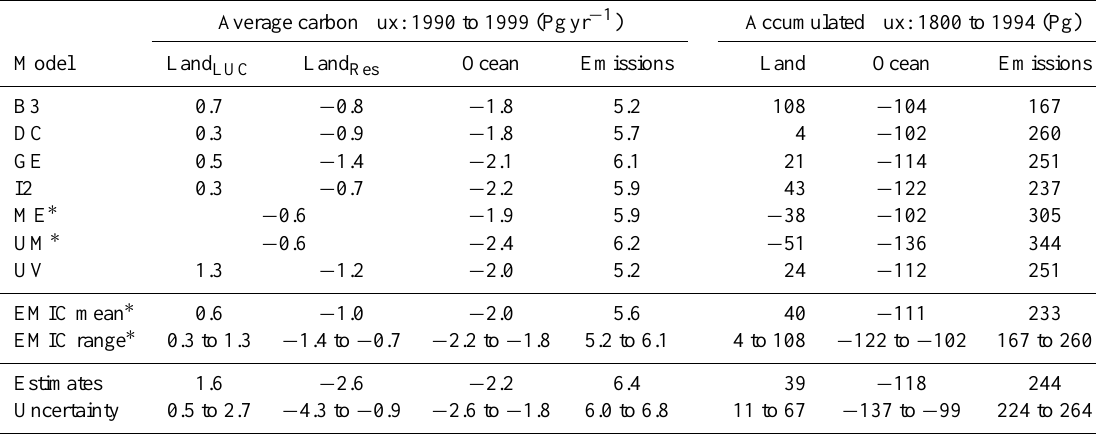
Table 3. Average carbon fluxes to the atmosphere over the 1990s and accumulated carbon fluxes from 1800 to 1994. Land LUC is an estimate of land-use change fluxes from simulations with only land-use forcing. Land Res is the residual land flux, which is derived from the land flux from a simulation with all forcing minus Land LUC . All other model fluxes are from differences between the all-forcing and control simulations. Estimates of average fluxes are from Table 7.1 of Denman et al. (2007), and estimates of accumulated fluxes are from Table 1 of Sabine et al. (2004). The change in atmospheric carbon storage between 1800 and 1994 is estimated to be 164 ± 4Pg in Sabine et al. (2004). Although the change in CO 2 between 1800 and 1994 was specified to be 75ppm in the all-forcing simulations, due to different estimates of atmospheric volume, the change in atmospheric carbon storage in the models is between 158 and